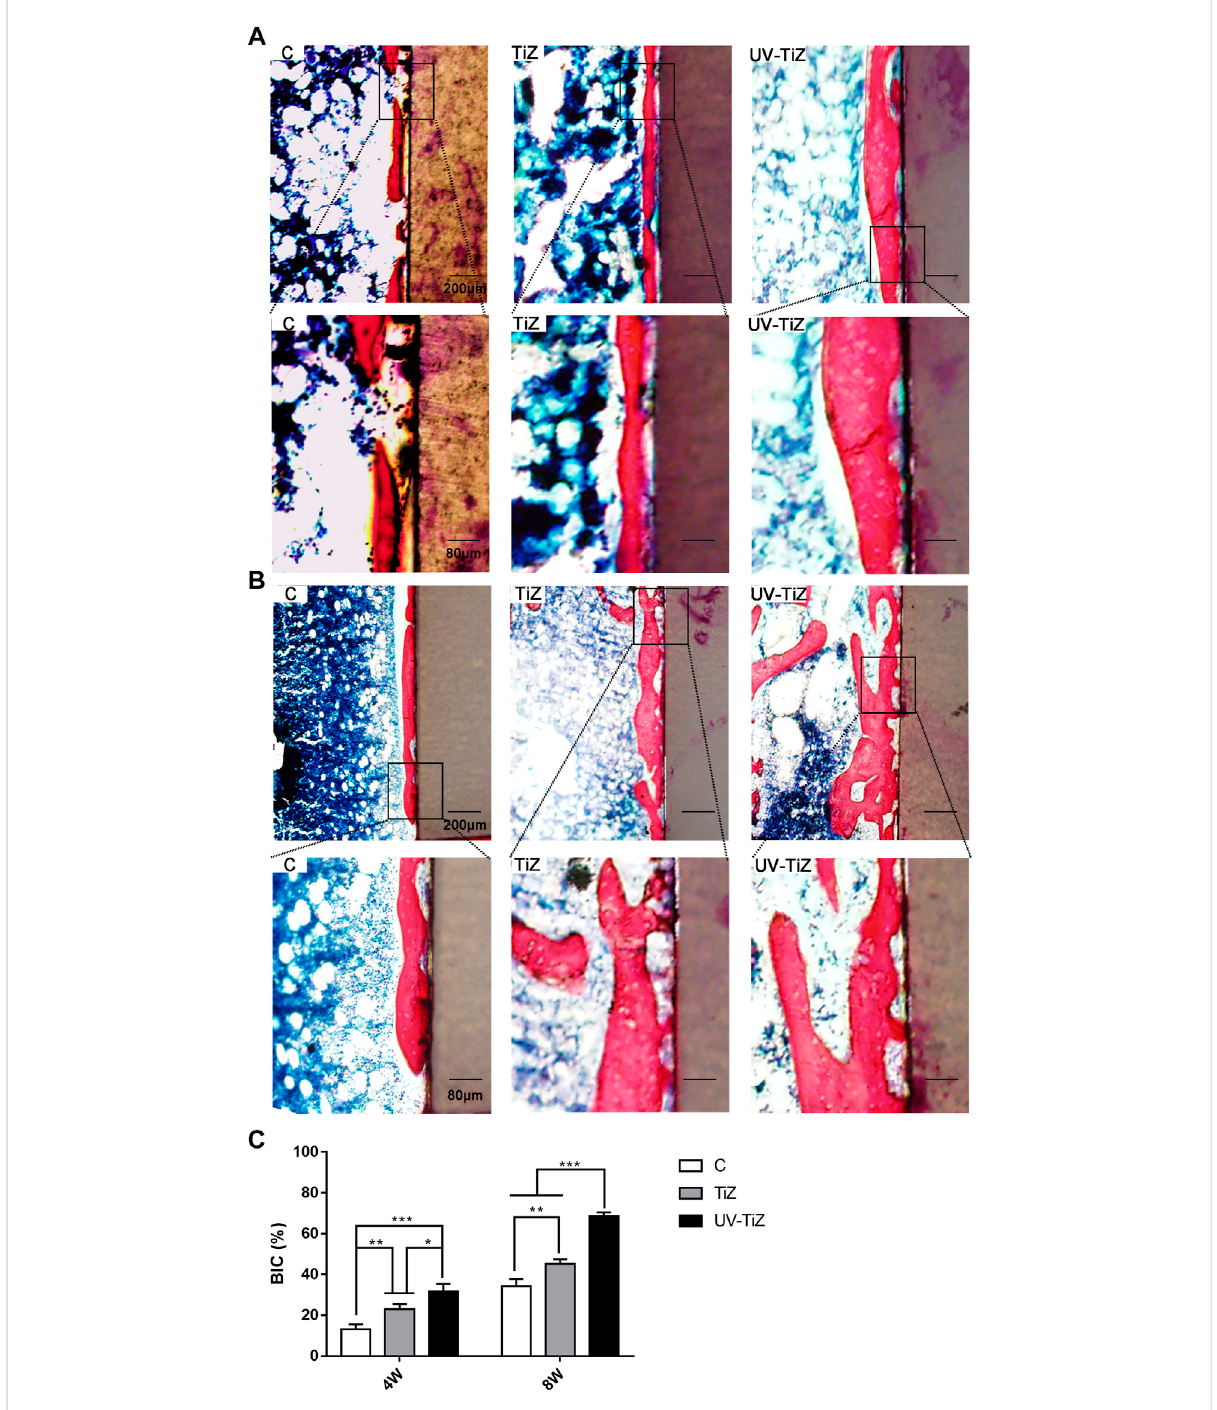
FIGURE 7 Histological analysis ofperi-implant newboneformationbymethylenebluefuchsinstainingafter4w (A) and8w (B) . (C) The percentage ofthe bone-implant contact (BIC) of different groups after 4 and 8 w. * p < 0.05, ** p < 0.01, *** p <